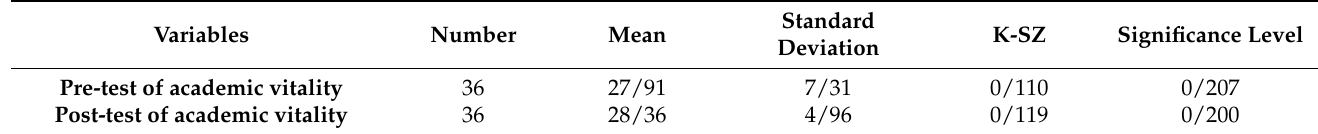
Table 7. Kolmogorov–Smirnov significance test for assessing the normality of academic vitality scores.